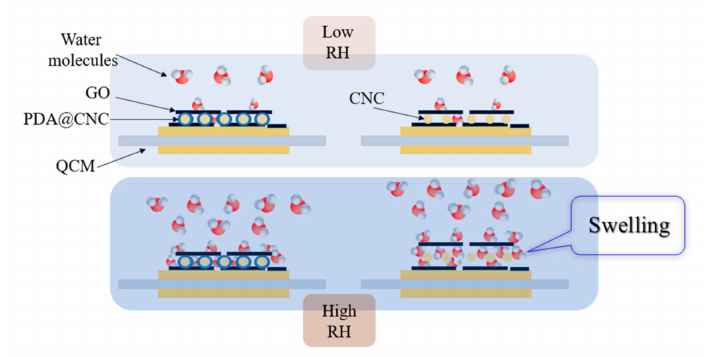
Figure 6. Illustration of the possible humidity sensitive mechanism of CNC / GO- and PDA@CNC / GO-coated QCM humidity